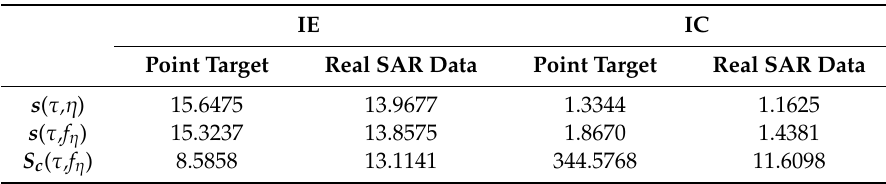
Figure 4. The coarse compression of real SAR data: ( a ) original echo data in the time domain, s ( τ , η ); ( b ) original echo data in the range of the Doppler domain, s ( τ ,f η ); and ( c ) data in the range of the Doppler domain after phase compensation, S c ( τ ,f η ). Table 1. Analysis of coarse